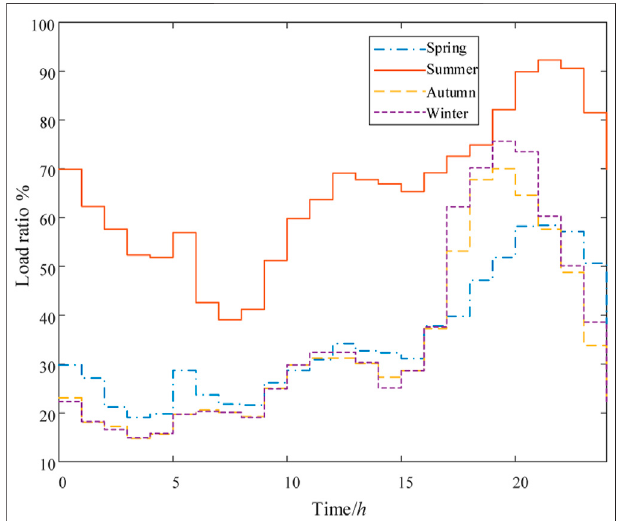
FIGURE 3 | Annual load curve of